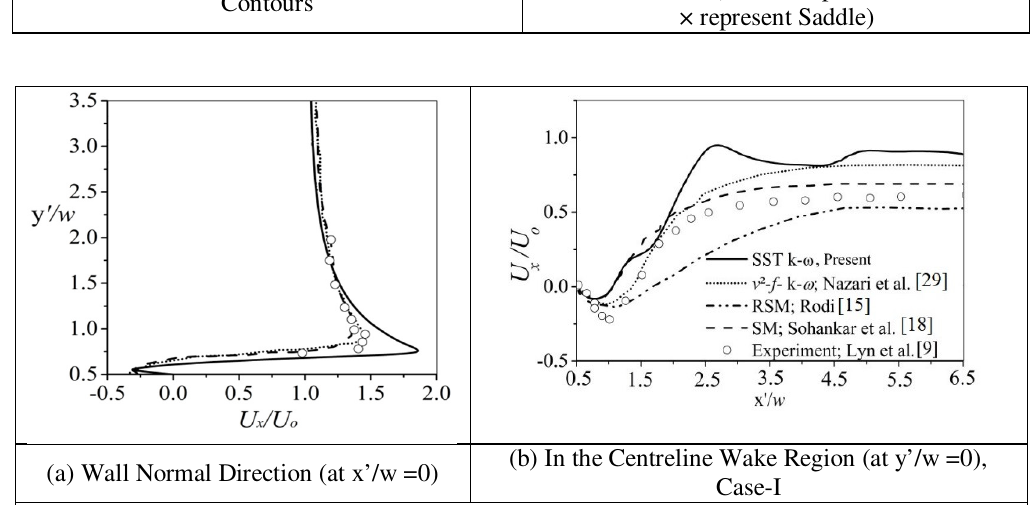
Fig. 3(d): Turbulent Kinetic Energy (k/U o2 ) Fig. 3(c): Streamwise Velocity (U x /U o ) Contours, Case-I (Here, + represent Centre, and Contours × represent Saddle)